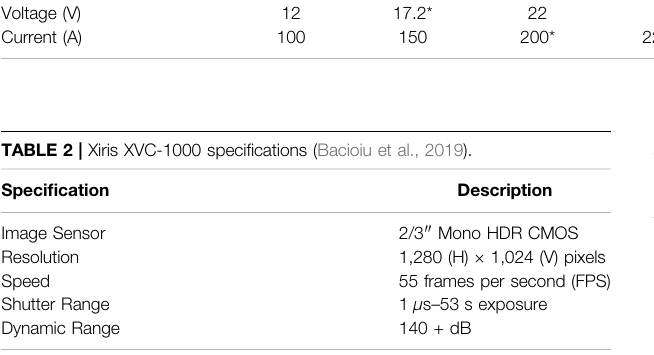
TABLE 1 | TIG welding process parameters (* baseline settings) [(Bacioiu et al., 2019)]. Parameters/Levels L1 Gas fl ow rate (L/min) Traveling speed (cm/min) Current (A)